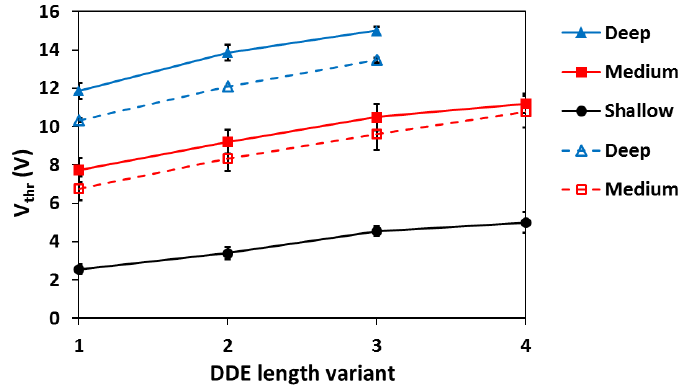
Figure 9. Experimentally measured threshold voltages in the 10 µ m pixel variants with high V pin (closed symbols, solid lines) and low V pin (open symbols, dashed lines) for the three DDE depths. The error bars indicate the spread in V thr calculated from the available samples.